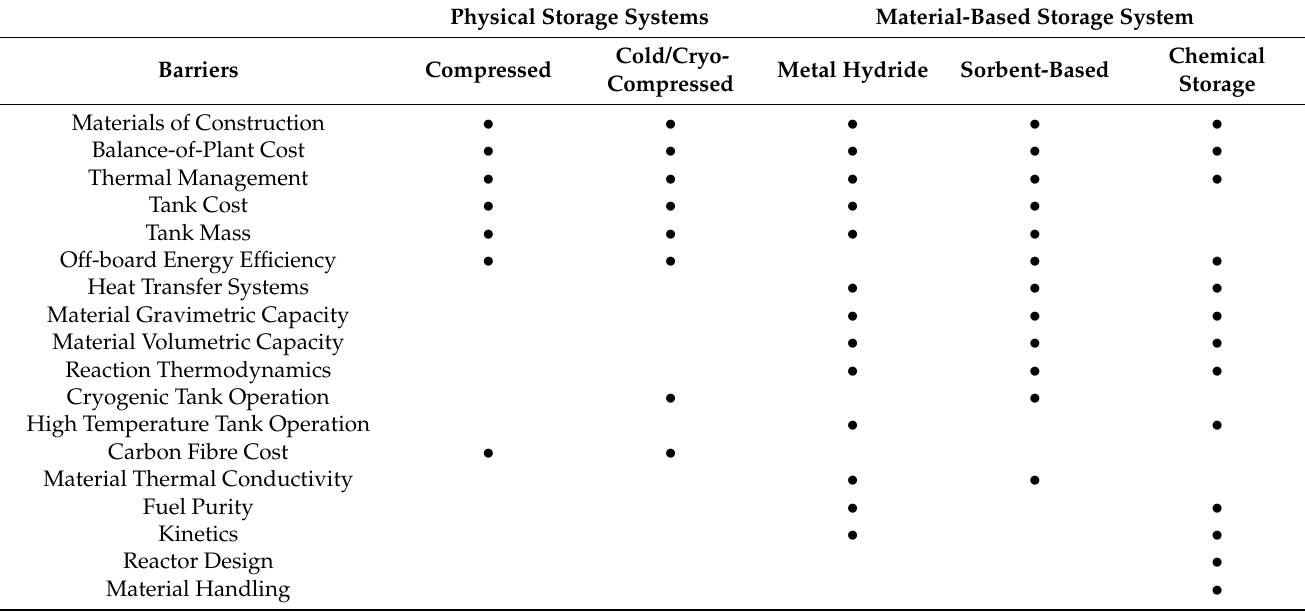
Table 9. Existing barriers for potential hydrogen storage systems [108,112].